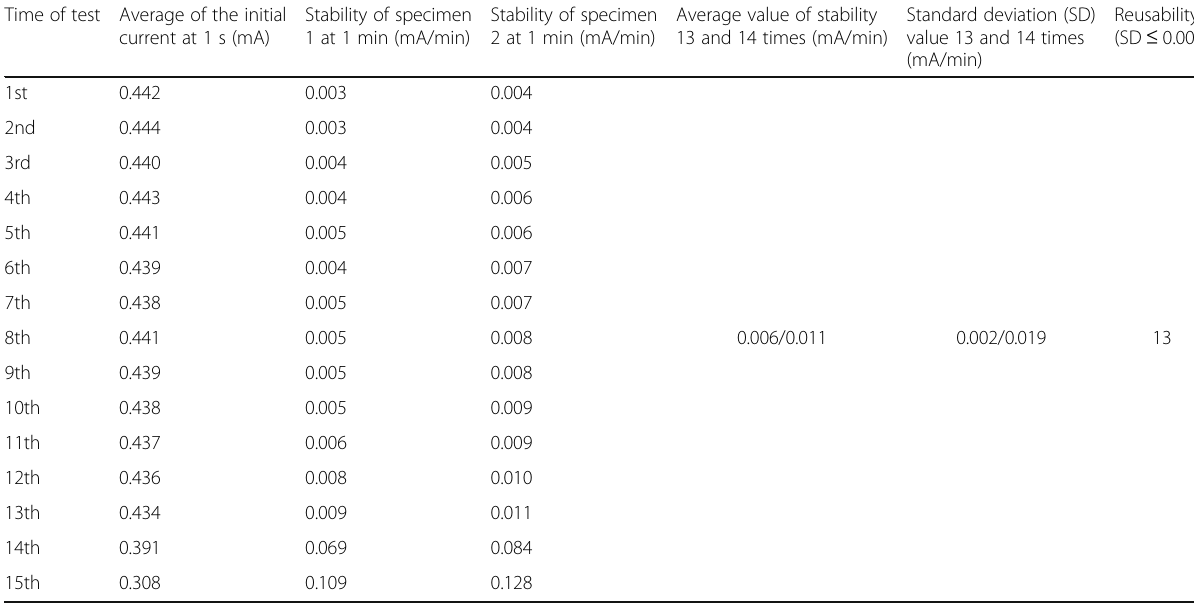
Table 1 Calculation of the values of the α -NiS nanosphere films for detecting 20 μ M glucose for average stability, standard deviation (SD), and reusability Time of test Average of the initial Stability of specimen Stability of specimen Average value of stability Standard deviation (SD) Reusability current at 1 s (mA) 1 at 1 min (mA/min) 2 at 1 min (mA/min) 13 and 14 times (mA/min) value 13 and 14 times (SD ≤ (mA/min)